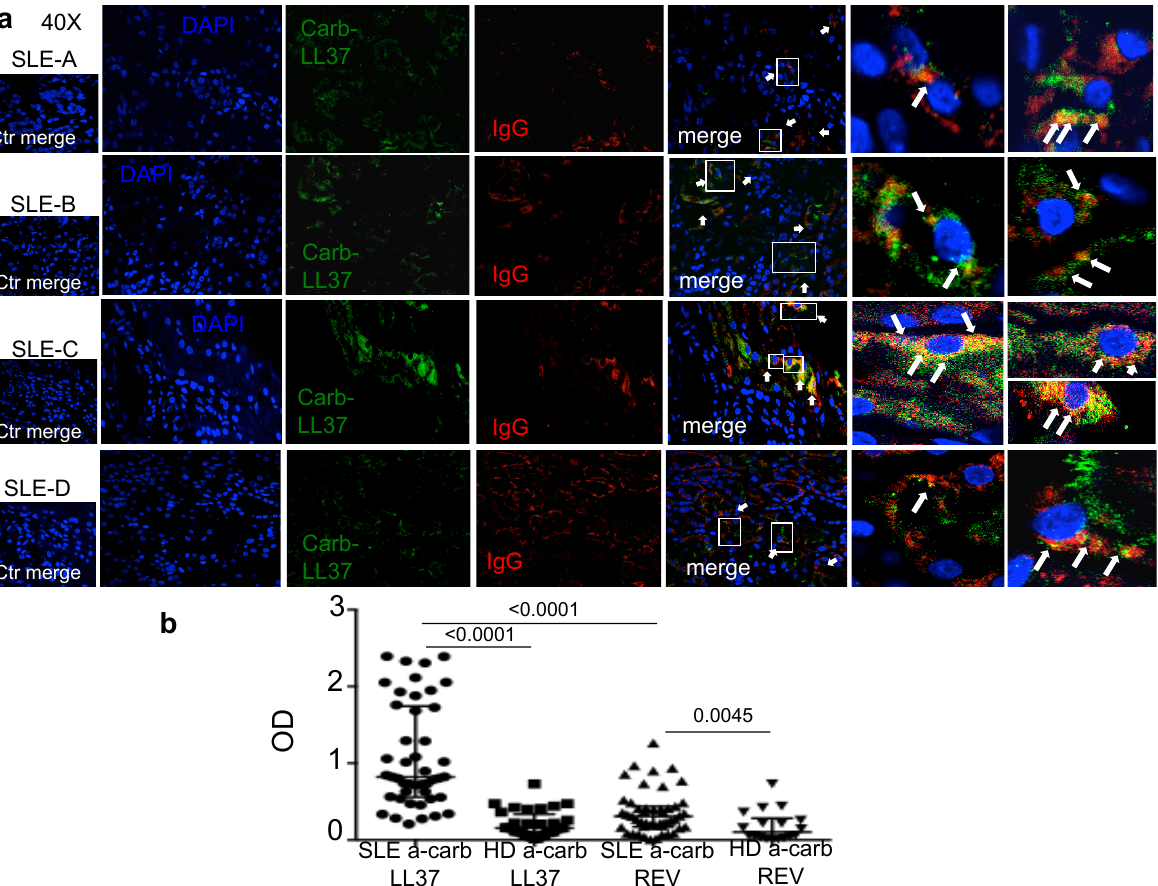
Figure 1. Carb-LL37 is present in Systemic Lupus Erythematosus (SLE) and is recognized by antibodies. ( a ) Representative confocal images of four out of six SLE-affected renal biopsies, showing expression of carb-LL37 and IgG. Two enlarged insets of confocal images for each SSc-patients, to evidence the co-localization between IgG staining and carb-LL37 staining are shown on the right. All stained biopsies were from lupus nephritis (class IV). White rectangoles represent the inset shown in the right side of the figure. White arrows show co-localization of carb-LL37 with IgG ( b ). Antibody reactivity of SLE and healthy donors’ (HD) sera to carb-LL37 and control carbamylated peptide REV (carb-REV), measured by enzyme-linked immunosorbent assays (ELISA) (and reported as optical density, OD). Medians with interquartile range are shown on the graph, p -values by Mann-Whitney’s